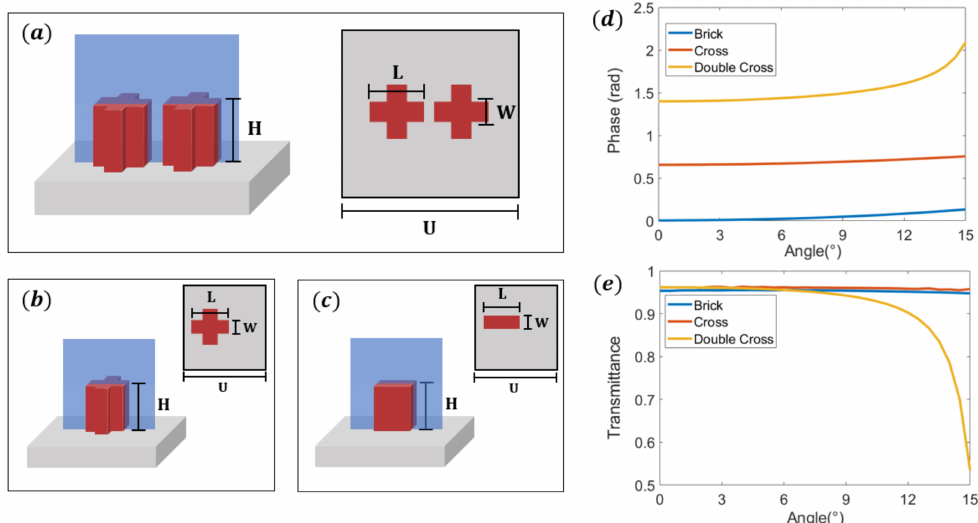
Figure 3. ( a – c ) Three kinds of unitcells, the dimension (L, W, H, U) of the structures here are L = 189 nm, W = 86 nm, H = 500 nm, U = 520 nm; ( d , e ) The transmission phase and transmittance of the three different nano-structures.